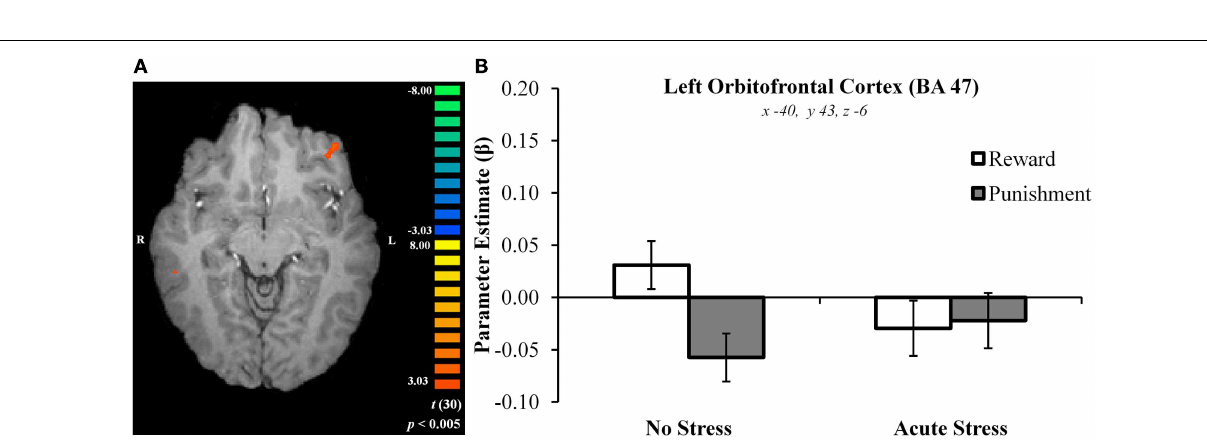
group. No significant main effect of sex on salivary cortisol was (Experimental Group: No Stress vs. Acute Stress) × 2 (Sex: male = 0.020, nor was a sig- observed, F (1, 25) = 0.52, p = 0.48, η 2 vs. female) repeated-measures ANOVAs to explore -the possible p nificant sex by experimental group interaction observed, F (1, role of sex in stress-related differences in processing of reward- = 0.001. Parameter estimates extracted 25) = 0.03, p = 0.87, η 2 related information. In the right caudate a trend towards a p from significant clusters in both contrasts were subjected to significant experimental group × sex interaction was observed, = 0.105. Post hoc a series of 2 (Outcome valence: Reward vs. Punishment) × 2 F (1, 28) = 3.27, p < 0.10, η 2 p